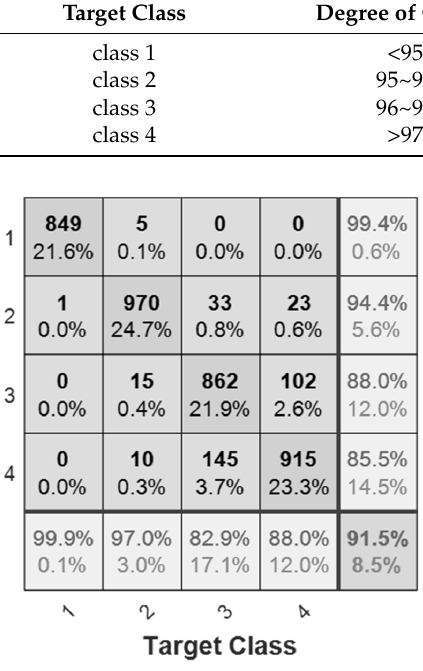
Figure 11. Output accuracy of ANN classifier.